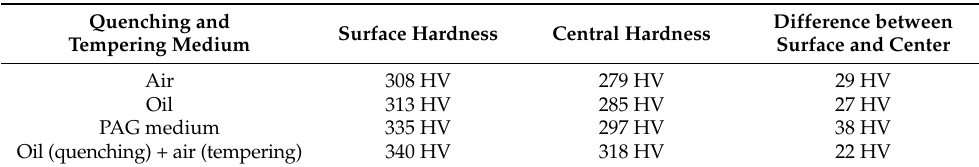
Table 7. Hardness of X6CrNiMoVNb11-2 steel by three tempering conditions at 650 ◦ C after quench- ing and tempering.